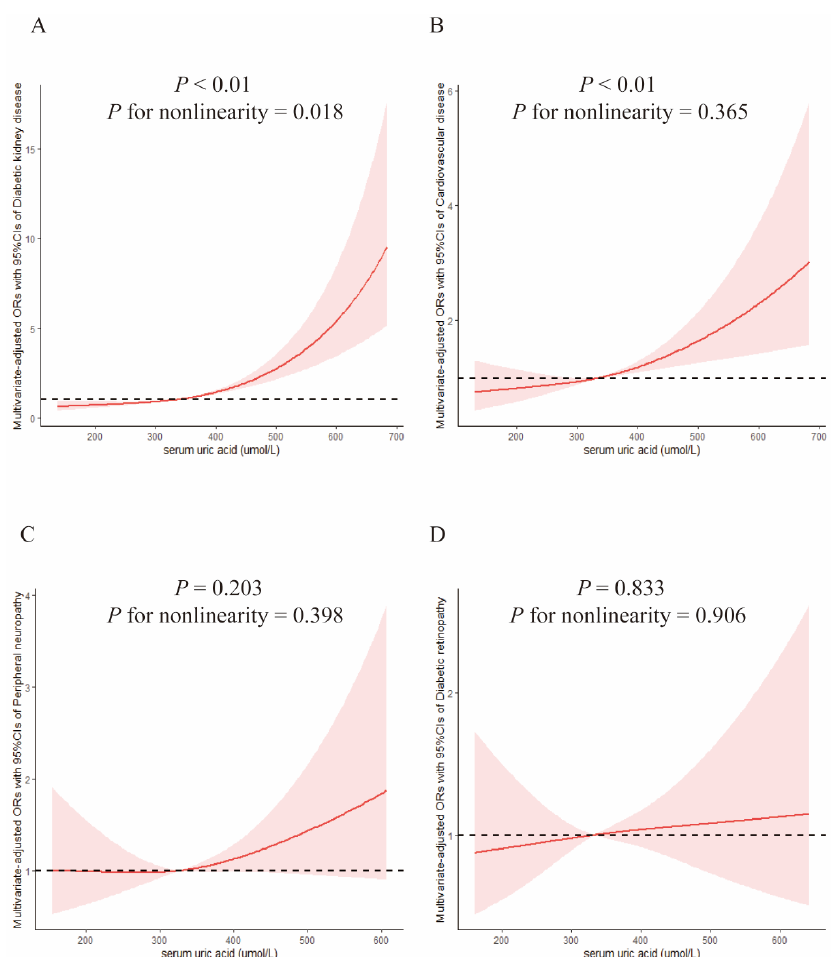
Figure 1. Examination of the dose–response relationship between serum uric acid ( µ mol/L) and the risk of diabetic chronic complications by restricted cubic splines model. The restricted cubic splines model adjusted for age, gender, race, poverty–income ratio, waist circumference, smoking status, education level, hypertension, serum triglyceride, total cholesterol, courses of diabetes, and HbA1c. ( A ) Diabetic kidney disease; ( B ) Cardiovascular disease; ( C ) Peripheral neuropathy; ( D ) Diabetic retinopathy.